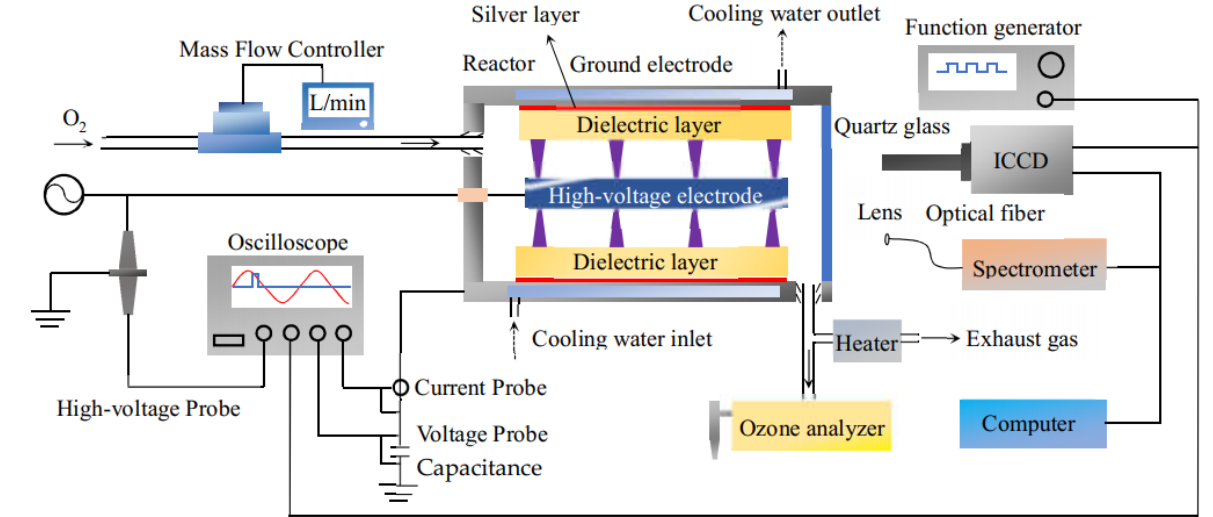
Figure 1. Schematic diagram of the experimental setup.